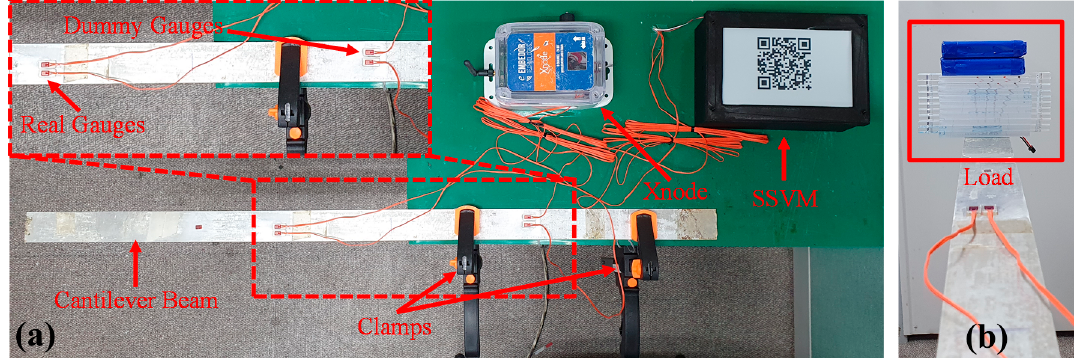
Figure 8. ( a ) Experimental setup for validation of SSVM; ( b ) loading.